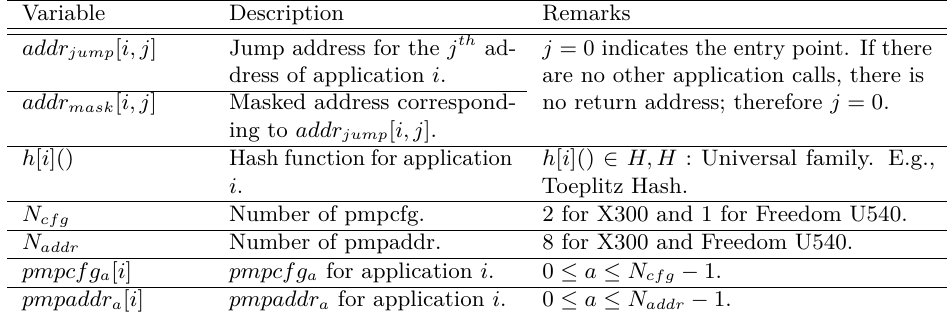
Table 5: Variable definition for jump-address